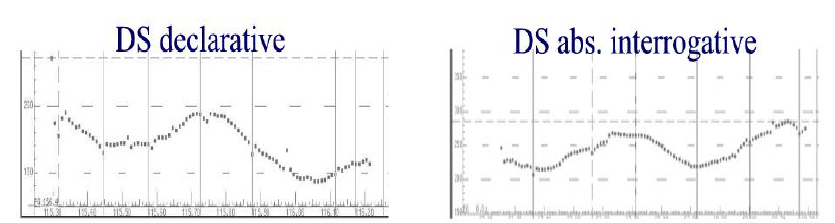
Figure 1: DS Spanish declarative and interrogative with a final tonal